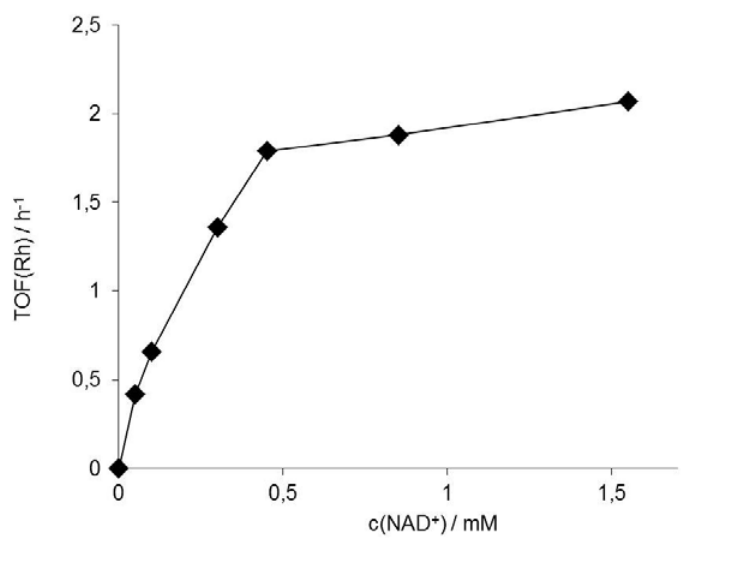
Figure 3. Dependence of Rh(III)-TsDPEN activity on c(NAD + ) Conditions: 50 mg Rh(III)-TsDPEN (0.35 μ mol), T = 30 °C, c(NaHCO 1,000